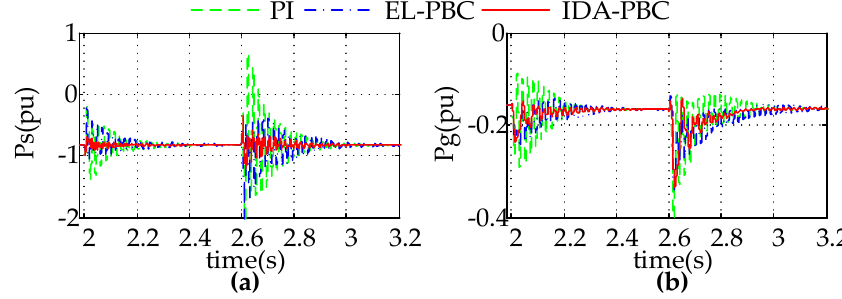
Figure 6. Suppressing the output active power fluctuation: ( a ) Stator active power; ( b ) Grid-side